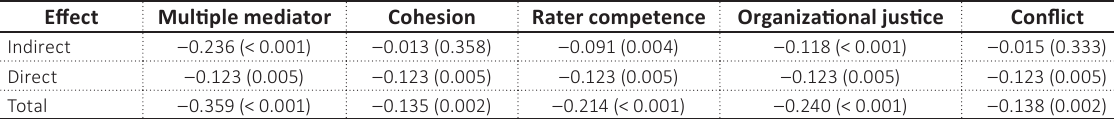
Table 7. Multiple mediators and specific indirect effect